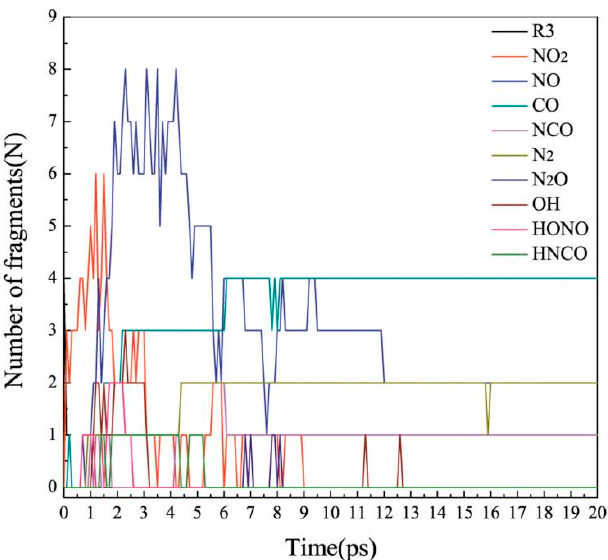
Figure 9. Time evolution of the number of main intermediates and products during the decomposition of the R3 crystal.